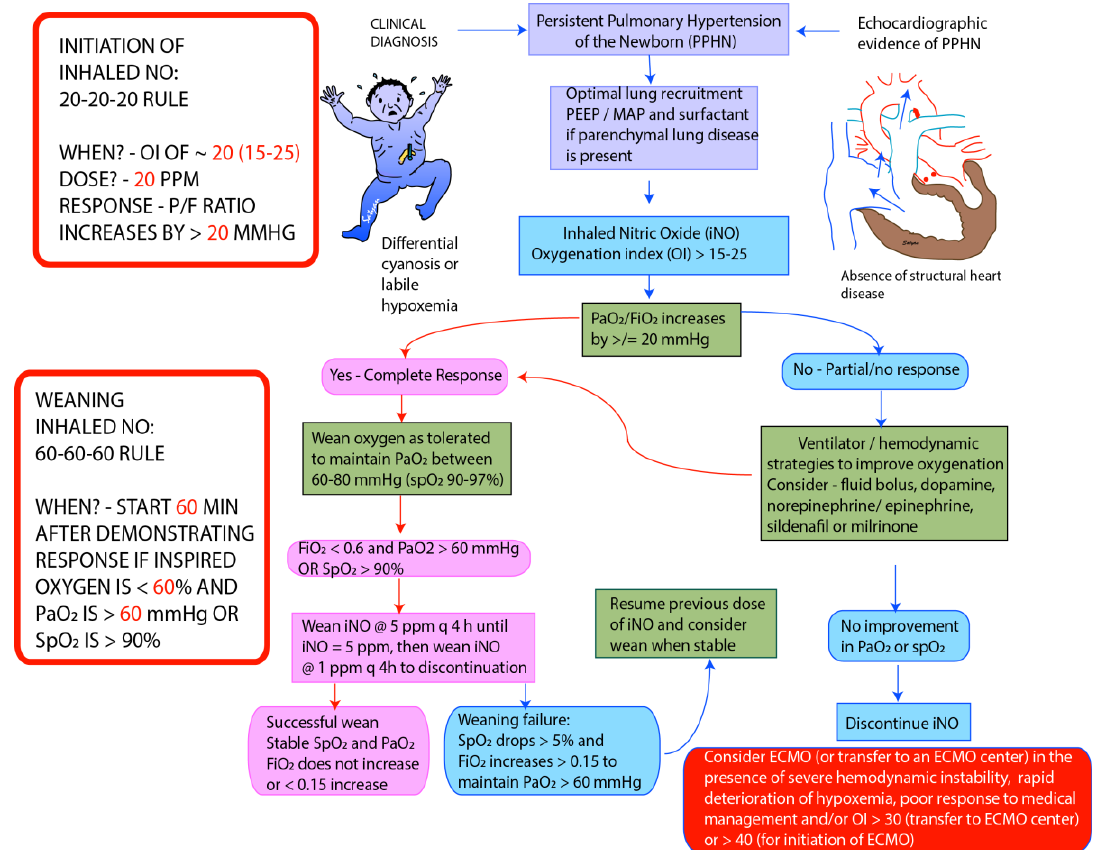
Figure 4. Guidelines for initiation and weaning iNO in PPHN/hypoxic respiratory failure (HRF)